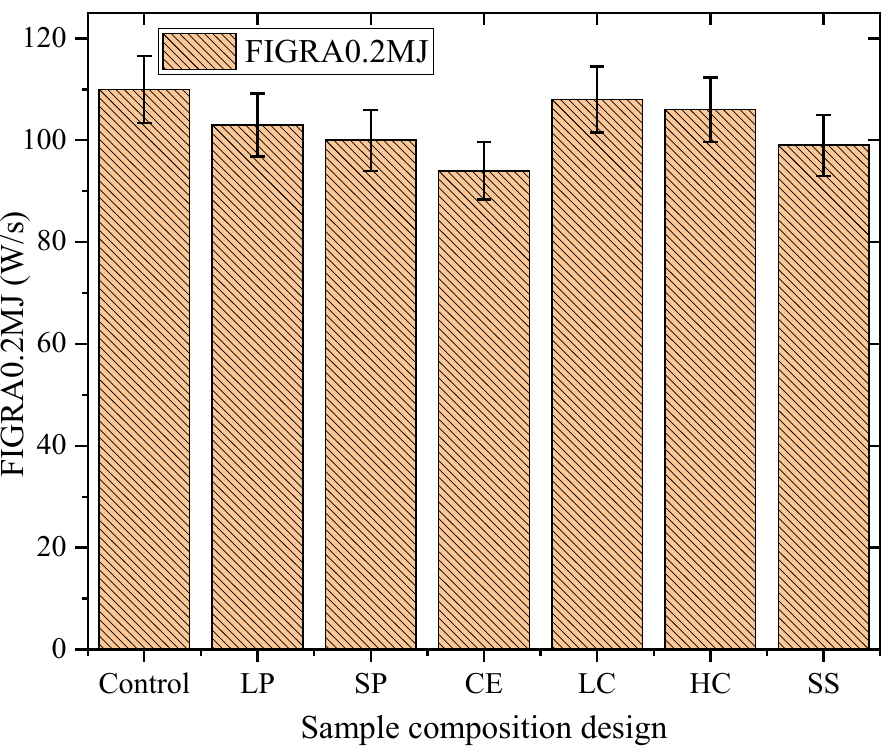
Figure 9. The results of FIGRA 0.2MJ. After being exposed in high temperature, EPS is melted, and the results of residue are shown in Figure 10. It can be seen that the residues of all test pieces are loose and honeycomb. As EPS is dispersed in the cement-based binder, no drops are produced